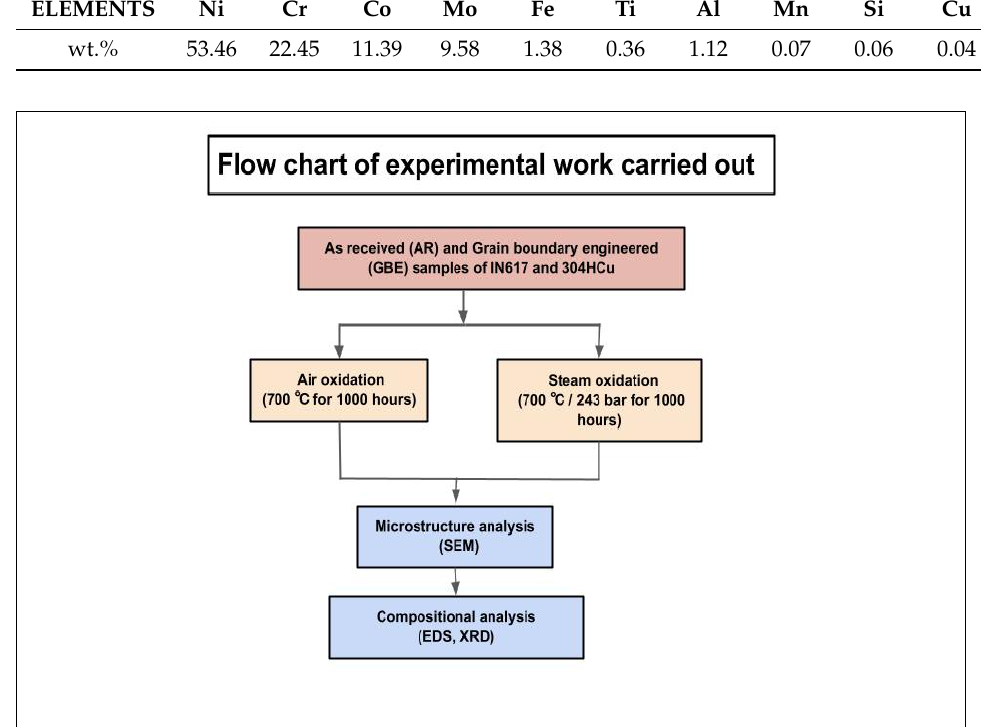
Figure 2. Experimental flow chart.